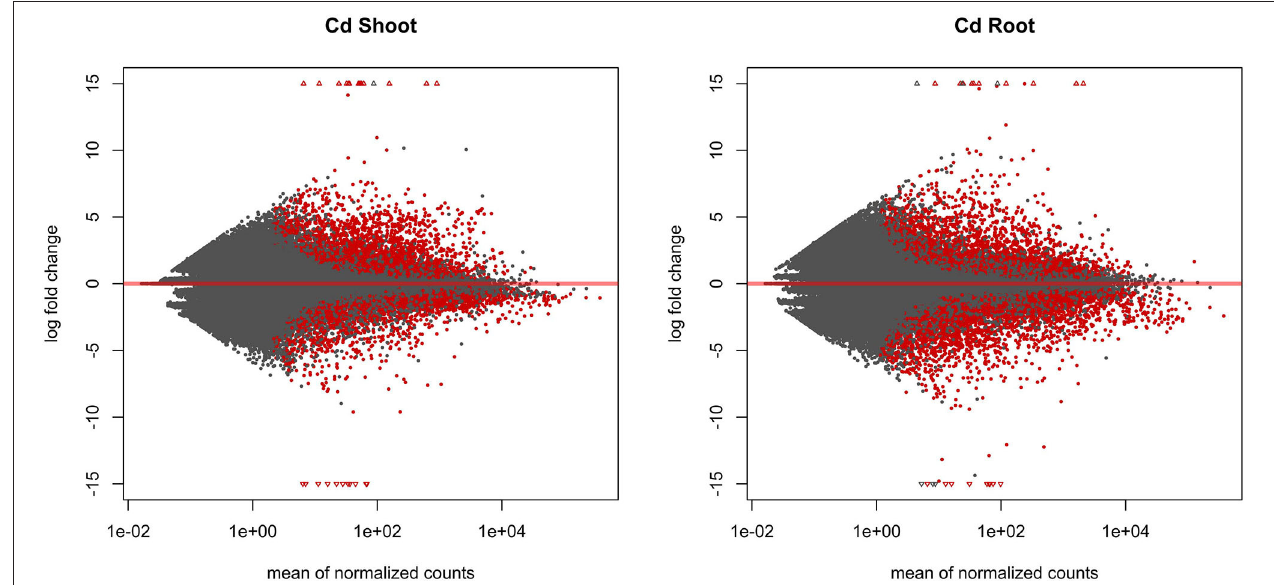
FIGURE 3 | MA plot displaying the log-fold change (logFC) for each gene against the mean of normalized counts in shoot and root tissue. Differentially expressed genes with a p -value below 0.05 are highlighted in red. The 10 most abundant gene ontology (GO) annotations for both roots and shoots were assessed for DE